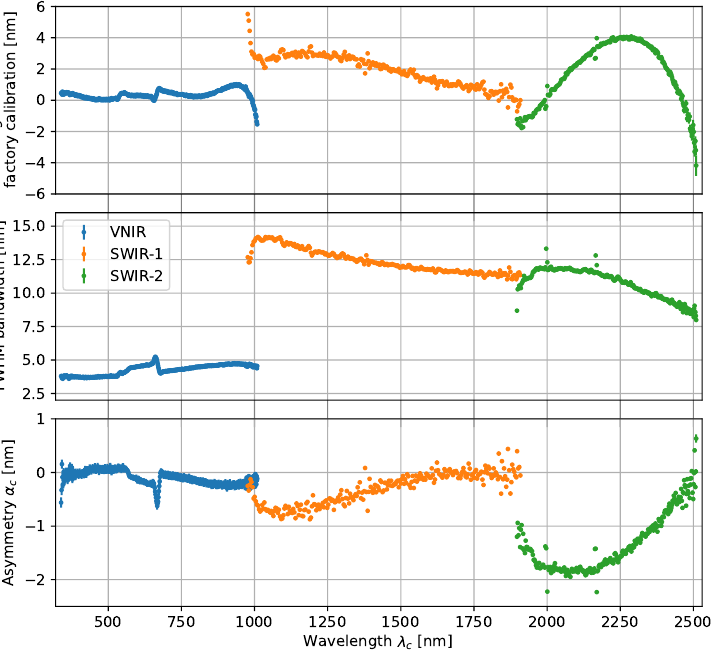
Figure 3. Spectral calibration results from an asymmetric Gaussian spectral response fits for all spectroradiometer channels. ( top ) Difference between the center wavelength λ c and the factory calibration from several years prior; ( middle ) full width at half maximum of the spectral response function; and ( bottom ) asymmetry parameter from the spectral response